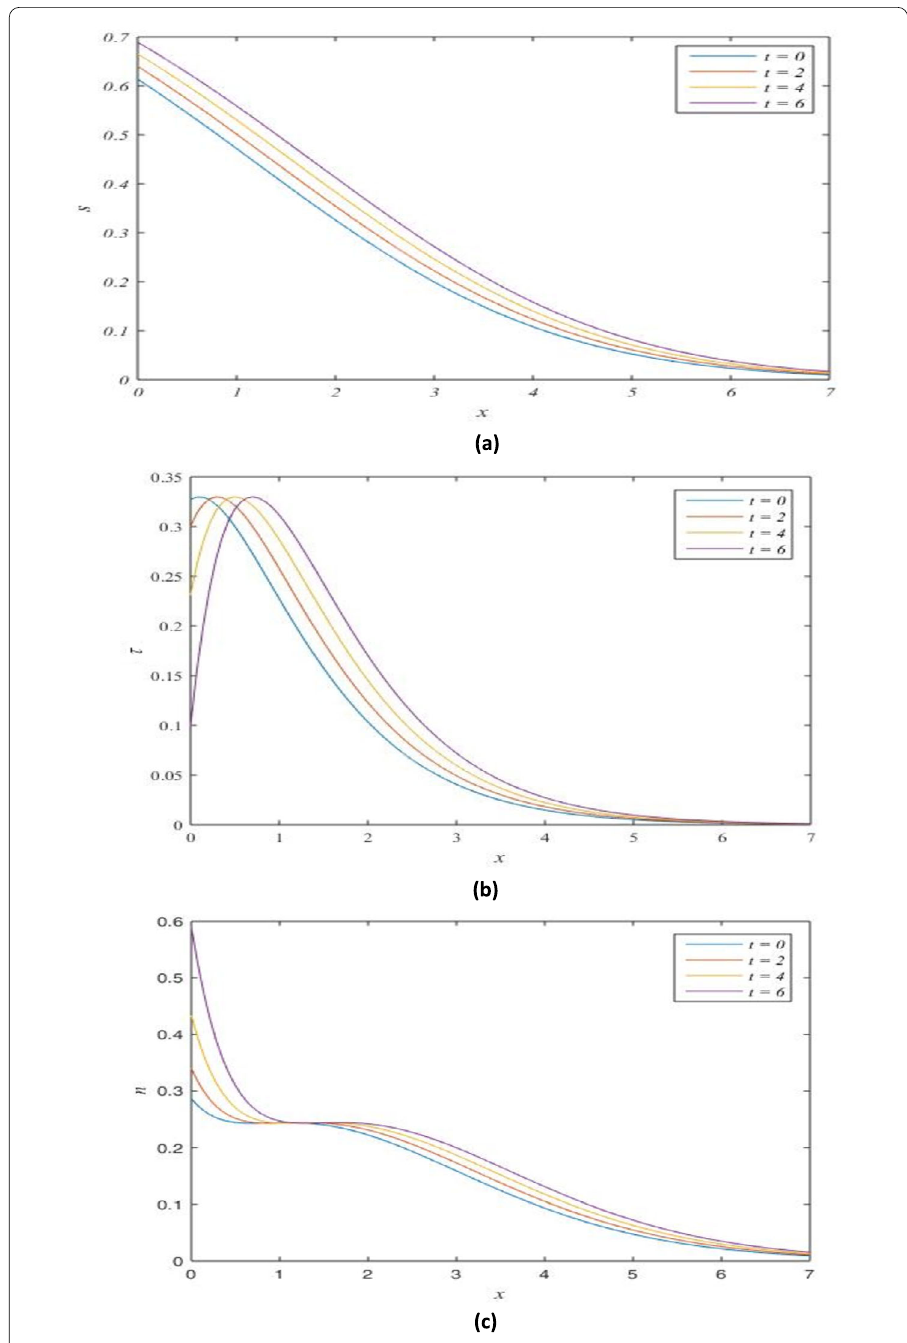
Figure 1 Traveling wave solution under no tagging. Plots of ( a ) total fish density s , ( b ) tagged fish density τ , and ( c ) untagged fish density n as functions of spatial dimension x for different time t between 0 and 6, as traveling waves moving from left to right. Here, c = 0.1, A = 1, B = 1, C = 0.6, D = 1.25, u = 0.05, τ 0 = 0.3, s